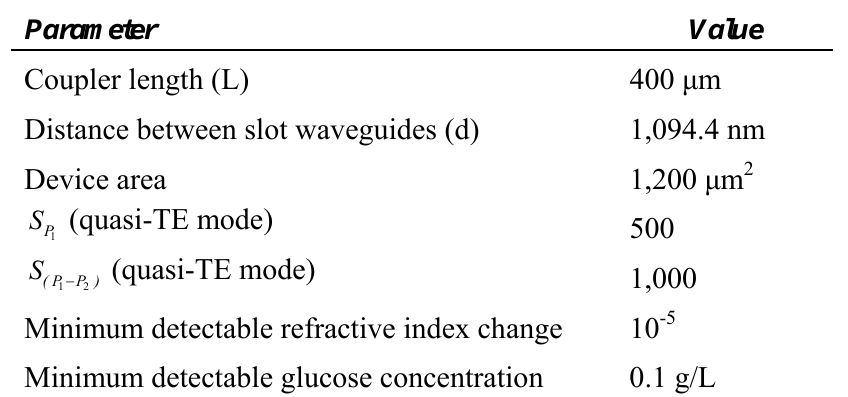
Table 3. Geometrical and performance parameters of the optimized directional coupler for optical chemical sensing (slot waveguides parameters are in Table